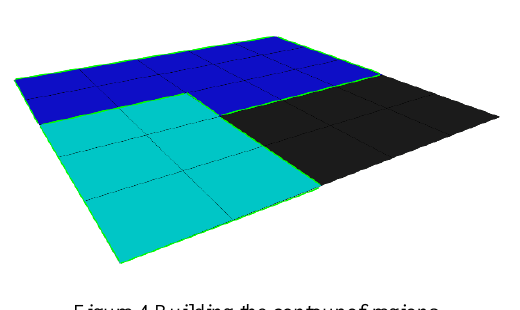
Figure 4 Building the contour of